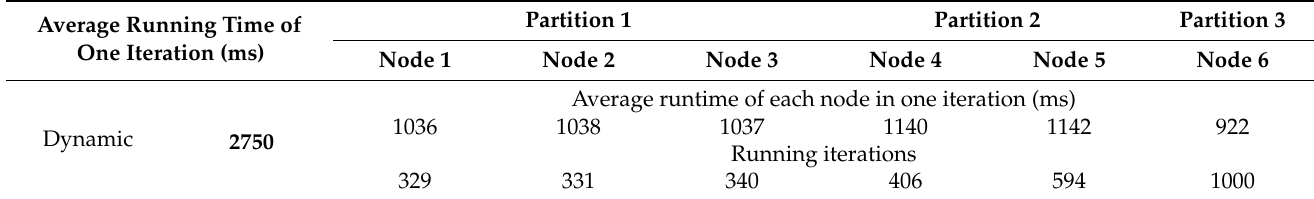
Table 6. Improved dynamic chain